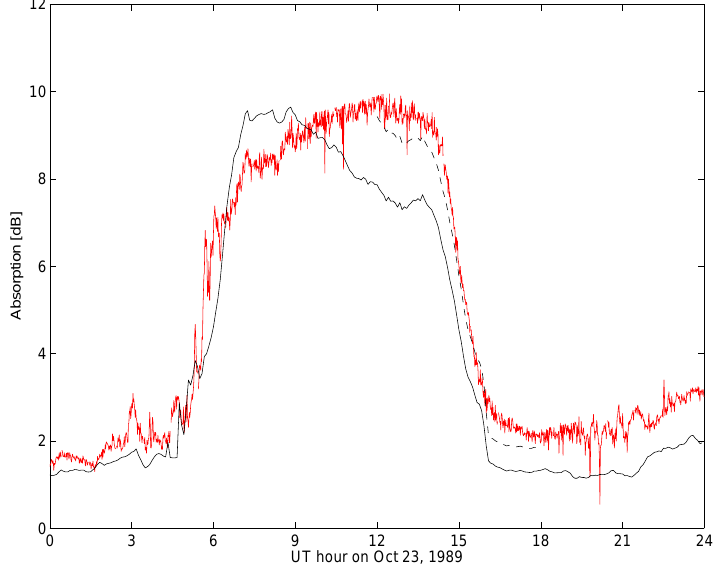
Fig. 8. Cosmic radio noise absorption as calculated from the model results (solid black line) and as measured by the Kilpisj¨arvi 30-MHz riometer (solid red line) 85km east of the modelling location. Also shown is the calculated absorption when taking into account the estimated constant relativistic electron precipitation (dashed black